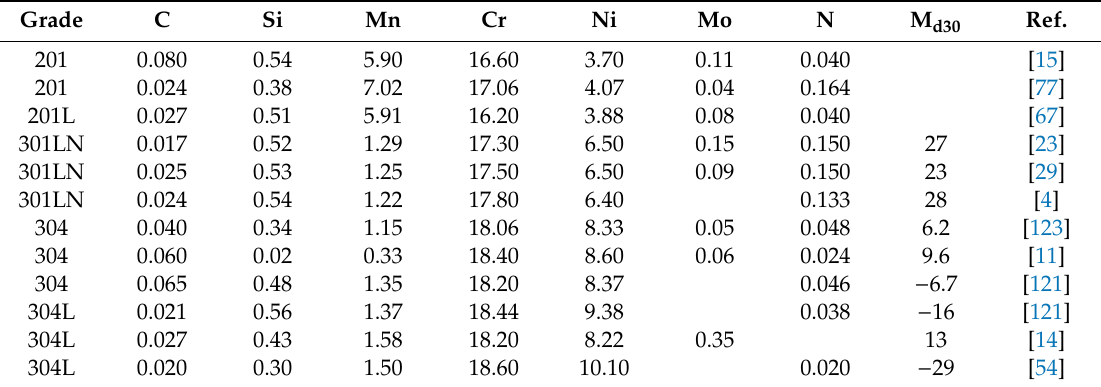
Table 1. Chemical compositions and Md 30 temperatures for Austenitic stainless steels (ASSs) in Figure